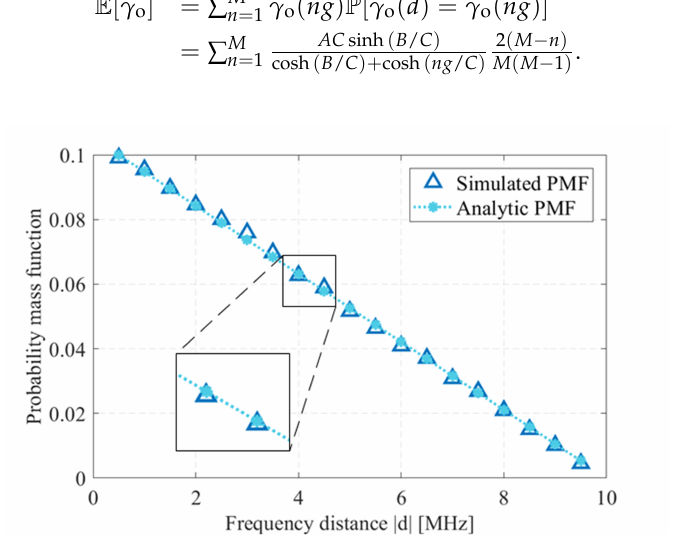
Figure 8. Probability mass function of frequency distance d with a frequency guard g = 0.5